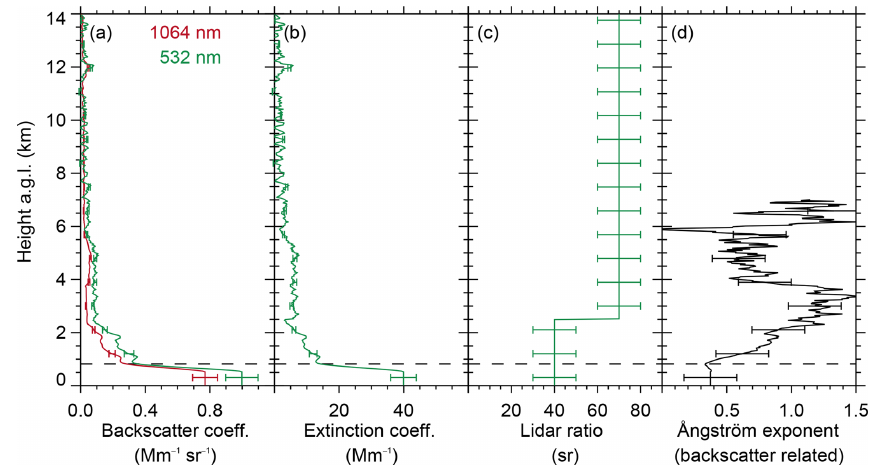
Figure 6. Vertical profiles of (a) particle backscatter coefficients at 532 and 1064nm, with error bars indicating 10% uncertainty, (b) particle extinction coefficient at 532nm, with error bars resulting from a lidar ratio uncertainty of ± 10sr, (c) particle lidar ratio, with error bars of ± 10sr and (d) backscatter-related Ångström exponent, with propagated error bars, derived by Polly XT on 2 March 2010, 06:15 to 09:00UTC. The planetary boundary layer top height is indicated by the dashed black